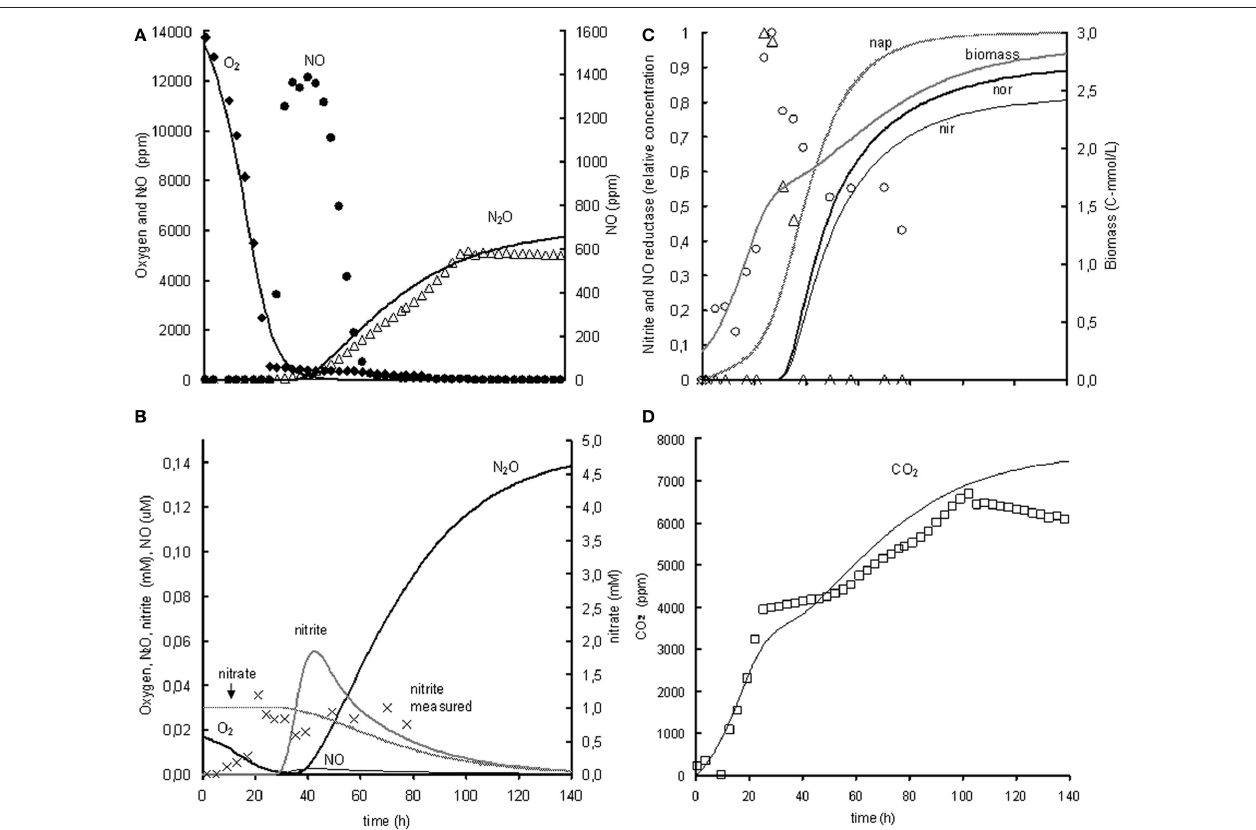
FIGURE 4 | Modeled (lines) and measured (points) concentrations when extrapolating the metabolic model to the experiment with 1% gas phase oxygen and 1mM nitrate. (A) Gas phase concentrations of O 2 ( (cid:4) ), NO ( • ), and N